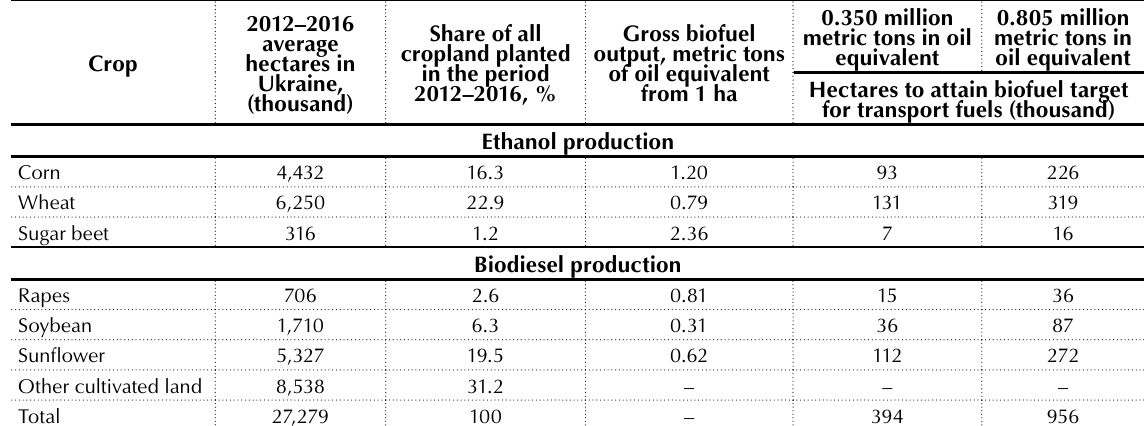
Table 3. Estimated hectares to meet Ukraine’s biofuel targets for transport fuels